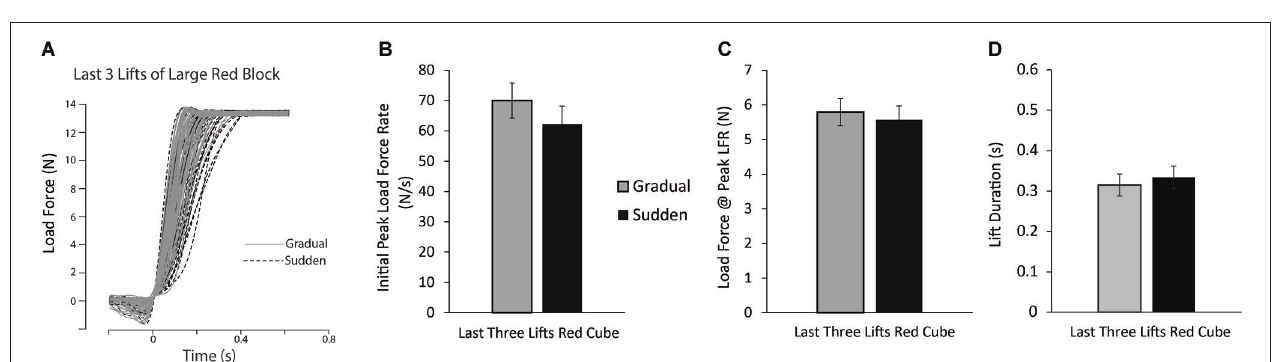
FIGURE 3 | Lift performance on first lifts of the large red block. (A) Load force records as a function of time from the first three lifts of the large red block for all participants in both the sudden (black dashed line) and gradual (solid gray line) lifting conditions. (B–D) Mean